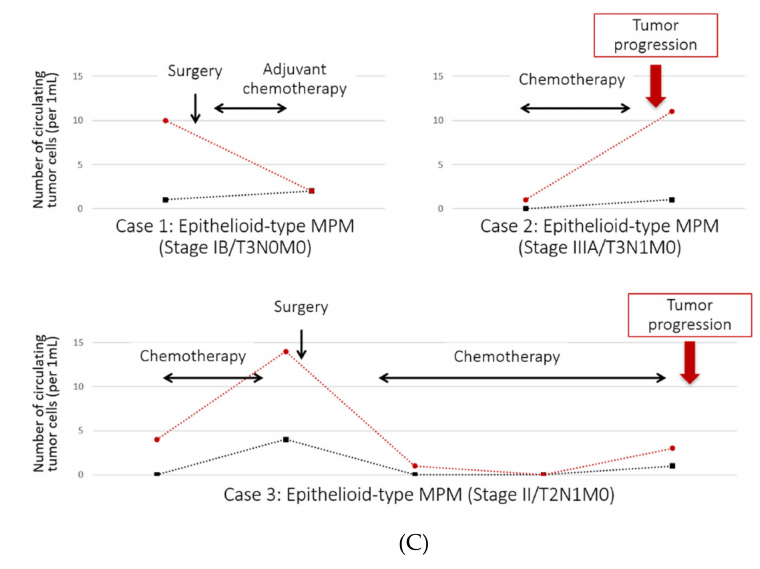
Figure 5. ( A ) The number of circulating tumor cells (CTC-count) detected with the CTC-chip in 1 mL of the peripheral blood sampled from 22 patients with malignant pleural mesothelioma (MPM). The CTC-chip was coated with an anti-podoplanin antibody, clone E-1 (E1-chip) or clone NZ-1.2 (NZ1.2-chip), for capturing tumor cells. A 1 mL of the peripheral blood taken from the same sample tube was applied to the E1-chip or the NZ1.2-chip. ( B ) The number of circulating tumor cells (CTC-count) detected with the CTC-chip in 1 mL of the peripheral blood sampled from 13 patients with epithelioid-type malignant pleural mesothelioma (MPM). ( C ) Changes in the number of circulating tumor cells (CTC-count) detected with the E1-chip (black lines and dots) or the NZ1.2-chip (red lines and dots) during treatment in some selected patients with malignant pleural mesothelioma (MPM). The median CTC-count detected with the NZ1.2-chip was 3 for epithelioid subtype and 0 for biphasic or sarcomatoid subtype, and the CTC-count was significantly higher in epithelioid MPM patients than in non-epithelioid patients (Figure 6). The CTC-count was not significantly di ff erent according to clinical stage (Figure 7A), but the CTC-count trended higher in advanced stage (stage III and IV) among epithelioid patients ( p = 0.051) (Figure 7B).